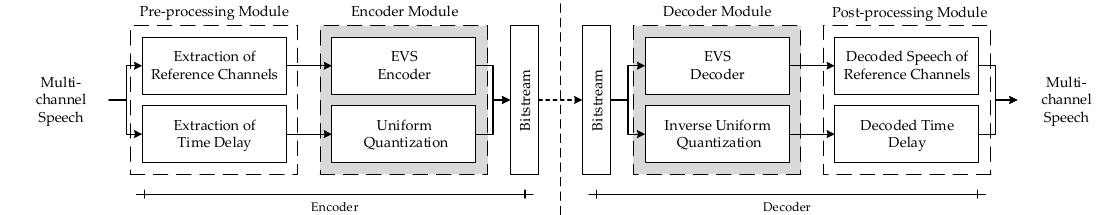
Figure 10. Block diagram of the Multi-enhance voice services (EVS)-TDOA.